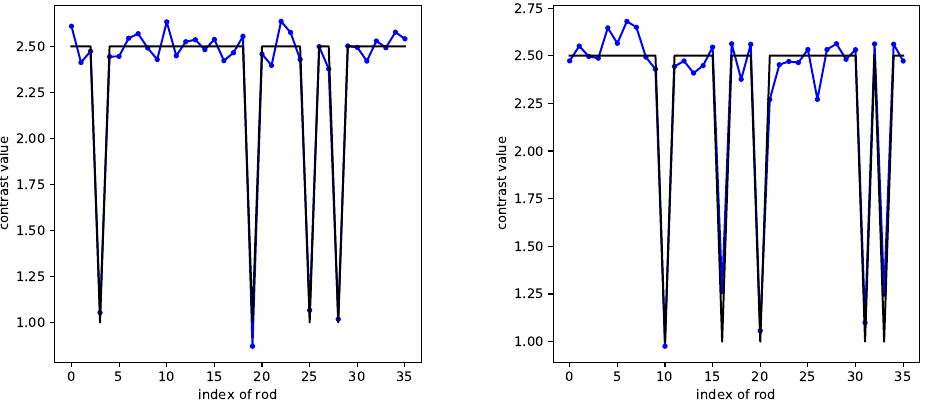
Figure 16. CRNN retrieval for four ( left ) and five ( right ) missing rods (the black line represents the ground truth, the blue line the CRNN